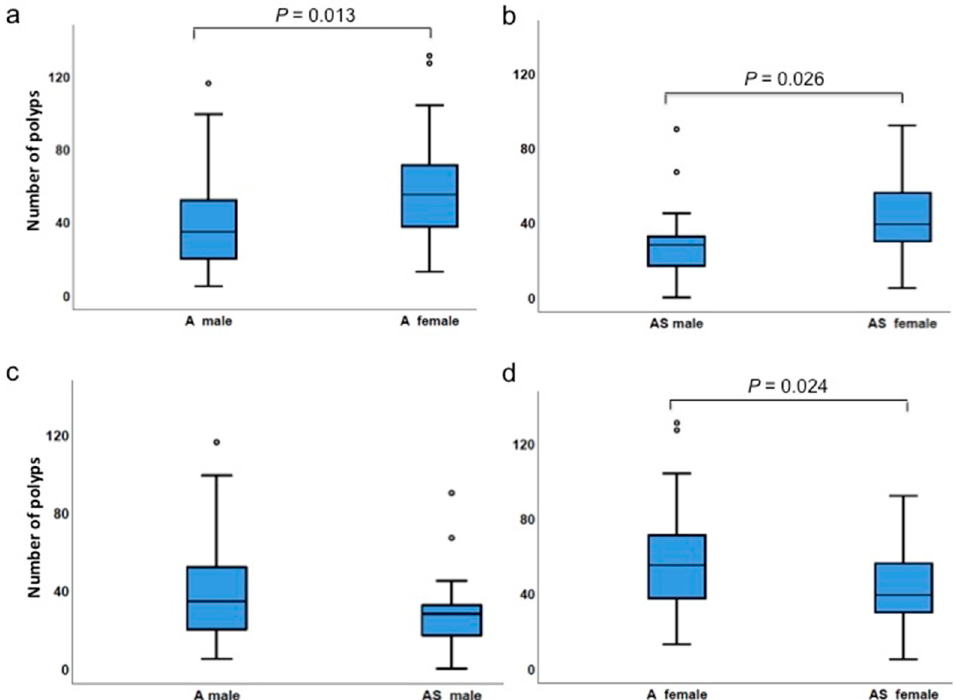
Figure 5. Difference between genders. ( a ) Comparison of polyp numbers in Apc Min/+ (A) males and females; ( b ) Apc Min/+ ;Sf1+/ − (AS) males and females; ( c ) Apc Min/+ and Apc Min/+ ;Sf1+/ − males; ( d ) Apc Min/+ and Apc Min/+ ;Sf1+/ − females. Quartile values are represented as described in the legend of Figure 2. Actual values are listed in Table